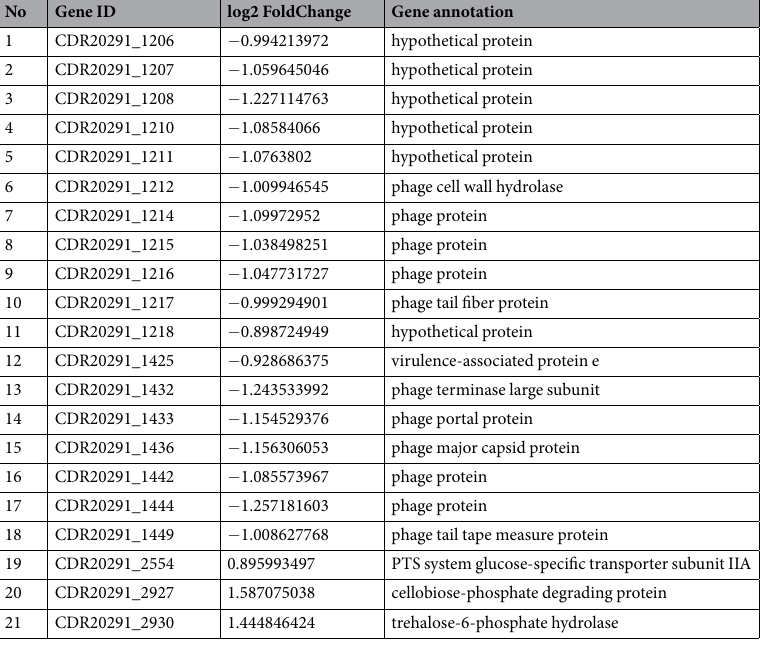
Table 1. Genes up - and down - regulated in luxS relative to the WT C . difficile Note: P-adjusted value ≤ 0.05.